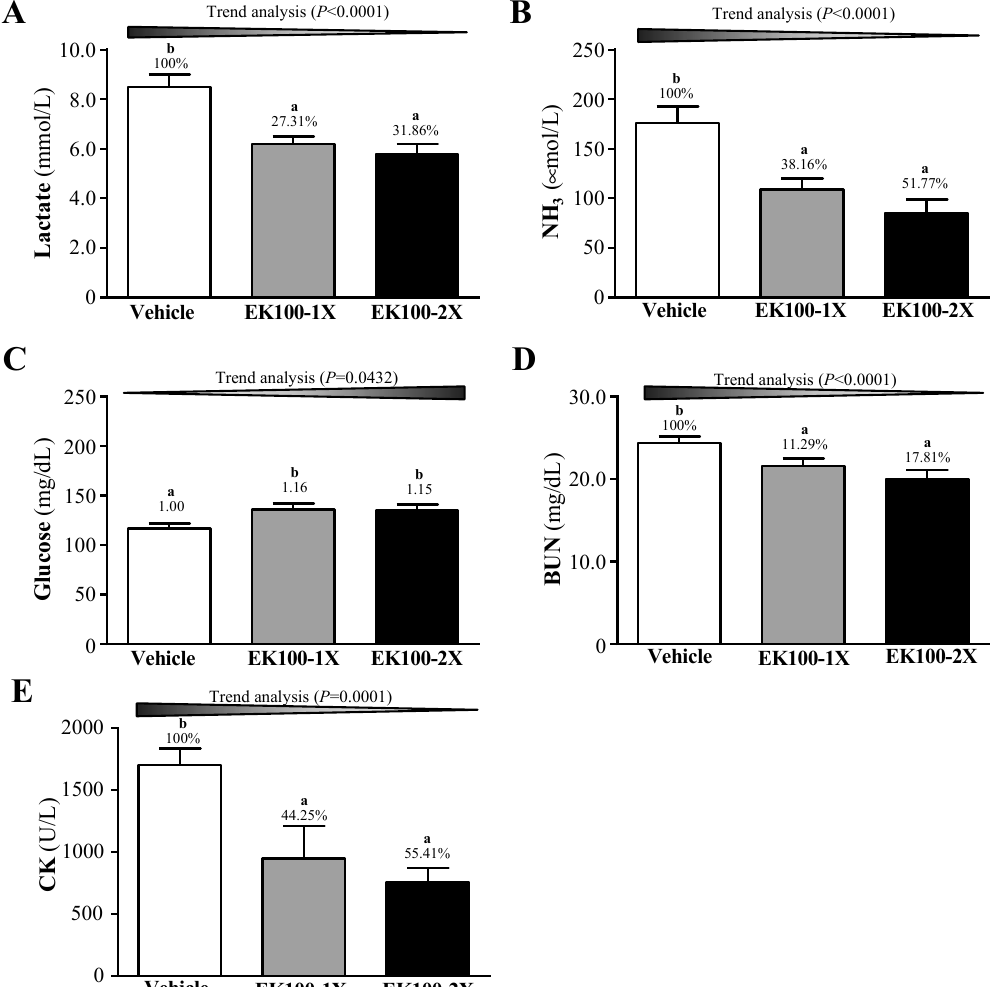
Figure 3. Effects of EK100 supplementation on serum ( A ) lactate, ( B ) ammonia, ( C ) glucose, ( D ) blood urea nitrogen (BUN), and ( E ) creatine kinase (CK) levels after an acute exercise challenge. Mice were supplemented with the vehicle, 10 and 20 mg/kg of EK100 for six-weeks. One hour after the last treatment dose was administered, a 15-min swimming test was performed without weight loading and serum was obtained immediately after for analysis. Data is expressed as mean ± SEM of eight mice in each group. Columns with different letters (a, b) significantly differ by one-way ANOVA ( p < 0.05).